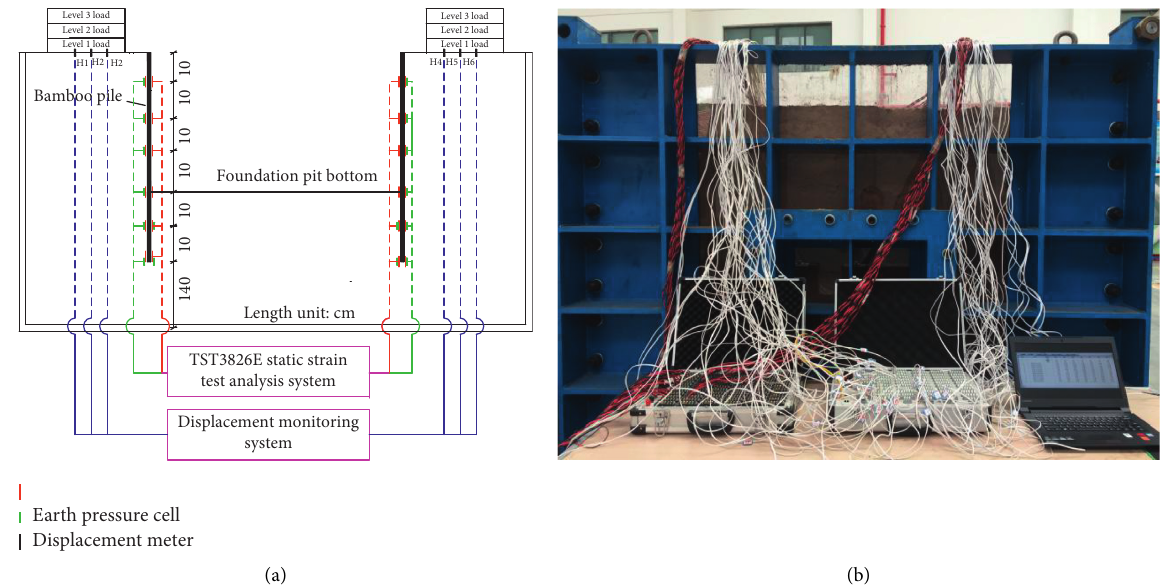
Figure 3: Layout of measurement points. (a) Schematic diagram of monitoring system. (b) Schematic diagram of on-site